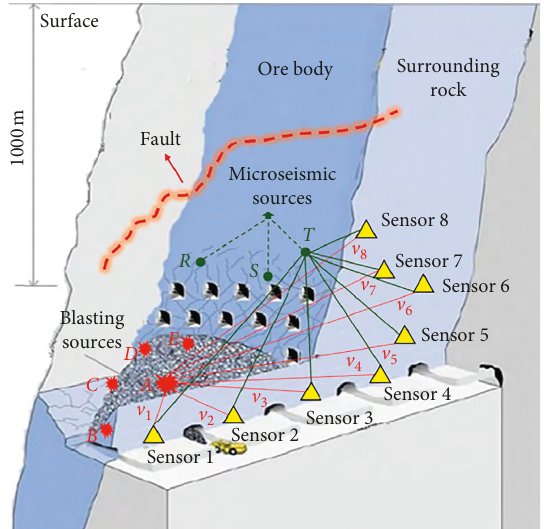
Figure 7: Propagation paths of P-wave with blasting sources and microseismic sources located at different coordinates. In the tra- ditional methods such as STT and STD methods, the average velocity value of blasting source A is equal to the average value of v1 to v8, which is calculated through their own distances and travel times. However, the average velocity values of other blasting sources B, C, D, and E will not equal the source A due to the anisotropy of rock. Similarly, the authentic velocity value of a microseismic source is not equal to the velocity value used in the localization process. Thus, they are inaccurate locating sources using the premeasured average velocity value of the blasting sources, where the velocity paths are different from the sources to be located